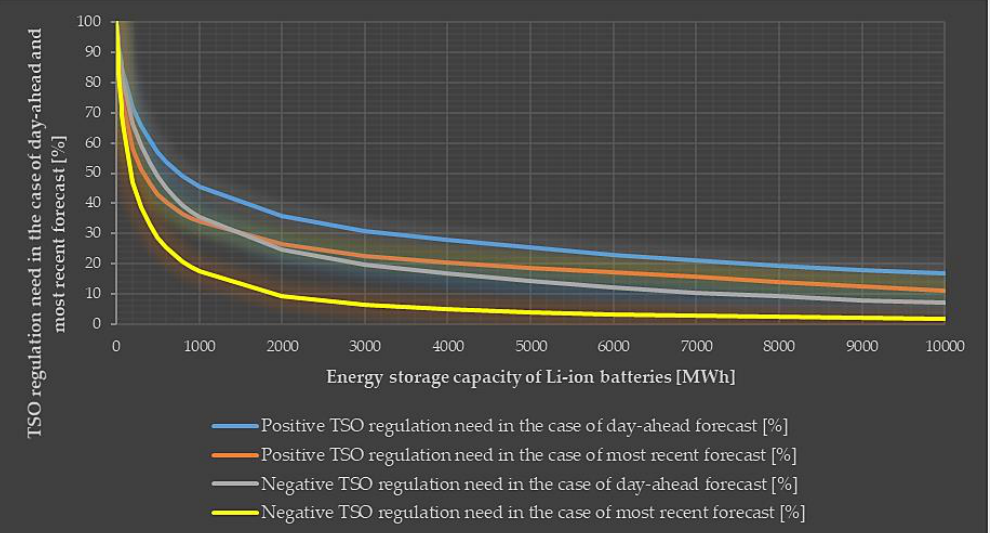
Figure 13. The relationship of negative and positive TSO regulation needs in the case of day-ahead and most recent forecast with different Li-ion energy storage capacities related to a 1000 MWp PV system for the period of 30/09/2014–30/09/2019.